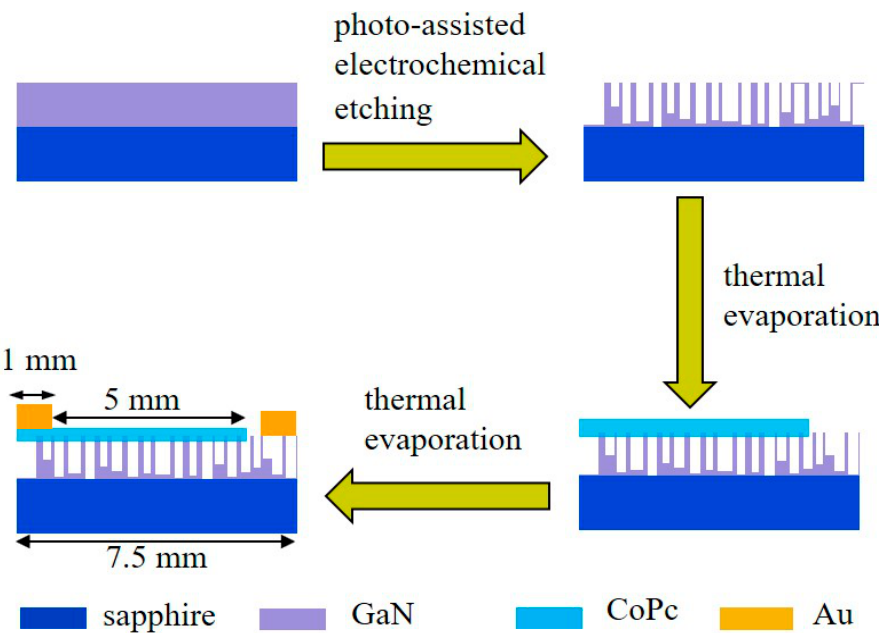
Figure 1. Schematic of the fabrication procedure of CoPc / porous-GaN p–n vertical heterojunction. porous-GaN: nanoporous GaN.